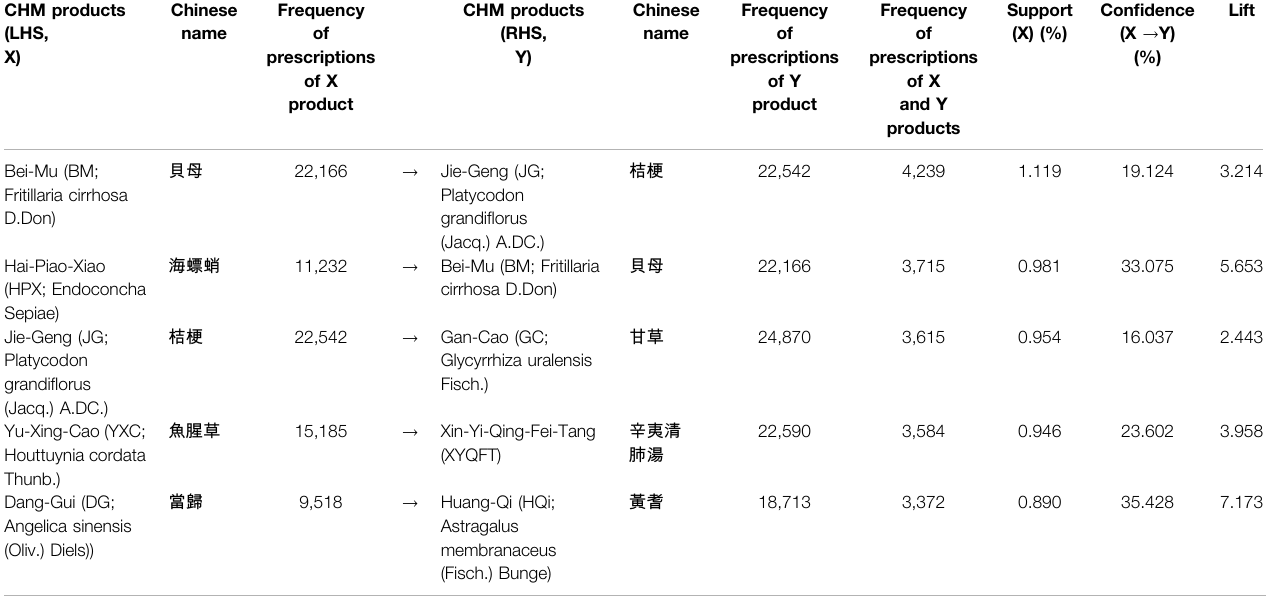
TABLE 5 | Most commonly used pairs of CHM products for patients with hereditary hemolytic anemias in Taiwan. CHM products (LHS,